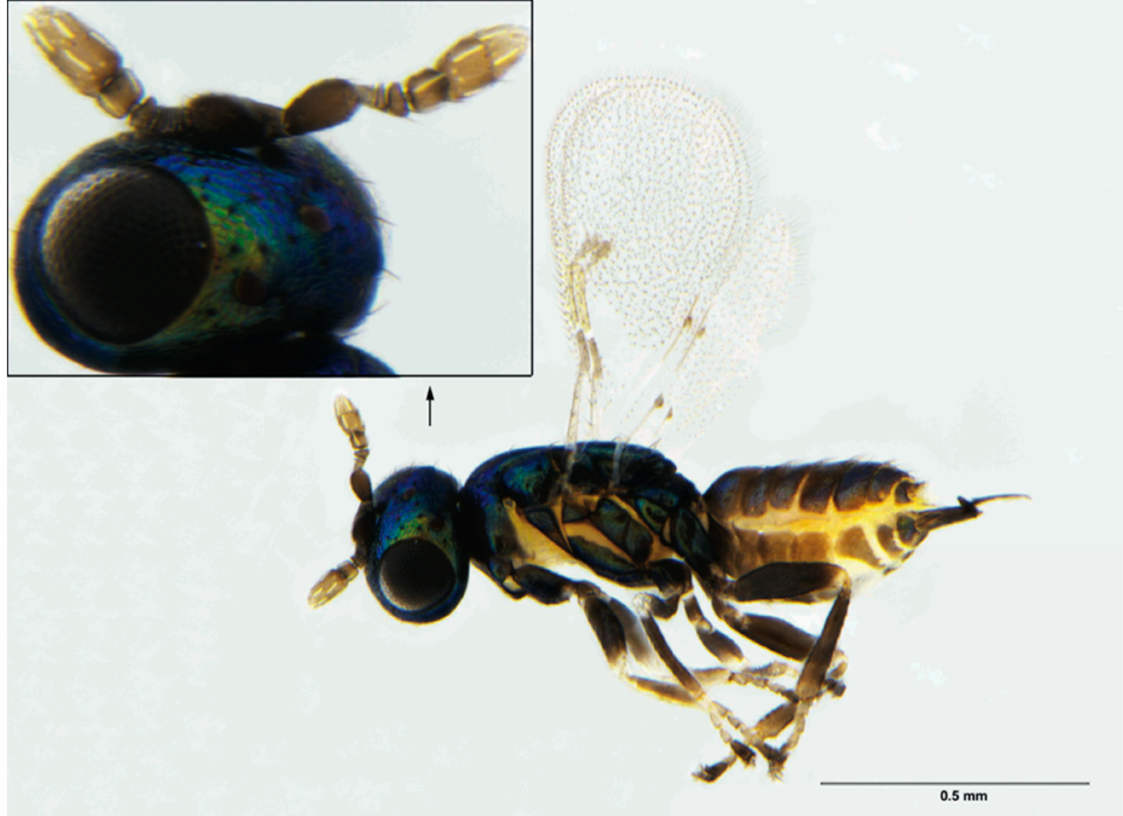
Figure 6. Ophelimus bipolaris sp. n., male, habitus with head in the excerpt, lateral